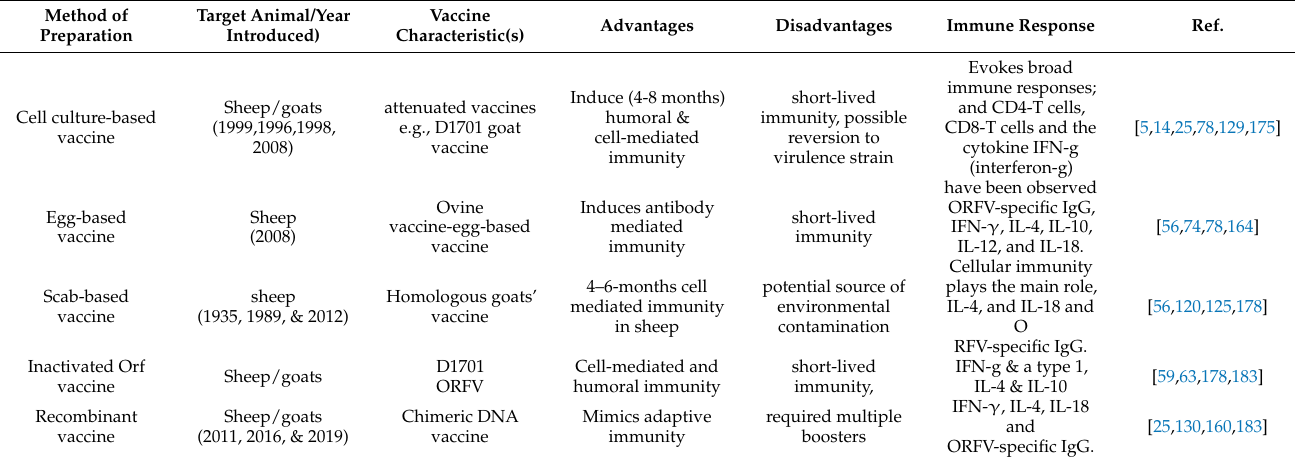
Table 3. Current vaccine platform strategies against Orf virus